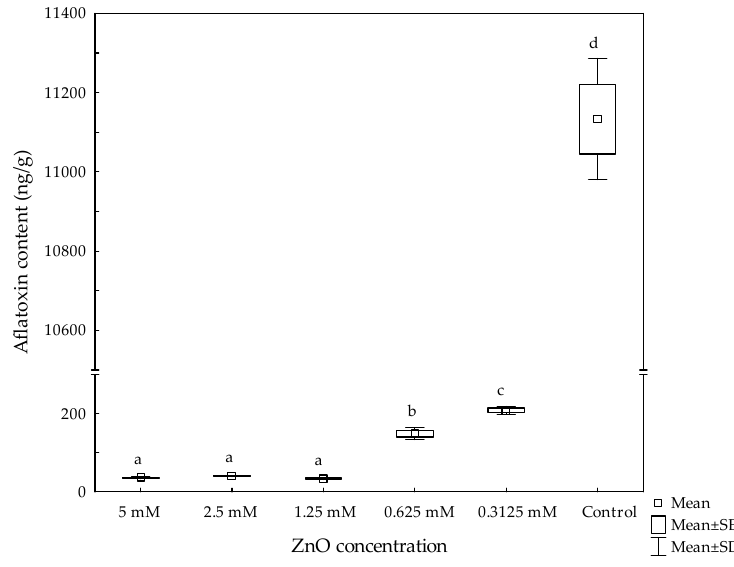
Figure 8. Effect of nanostructured ZnO on aflatoxin production in culture media. Boxes and whiskers not sharing a common superscript differ significantly (Dunnett < 0.05).